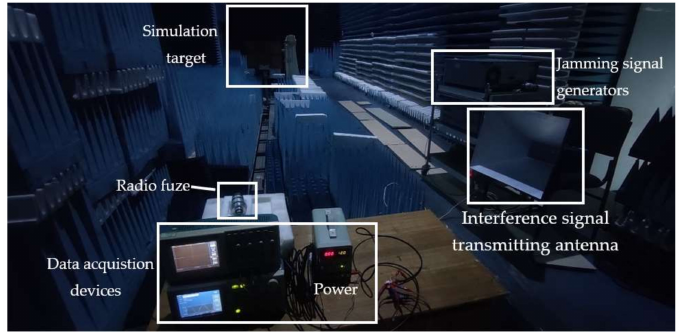
Figure 1. Data acquisition experiment